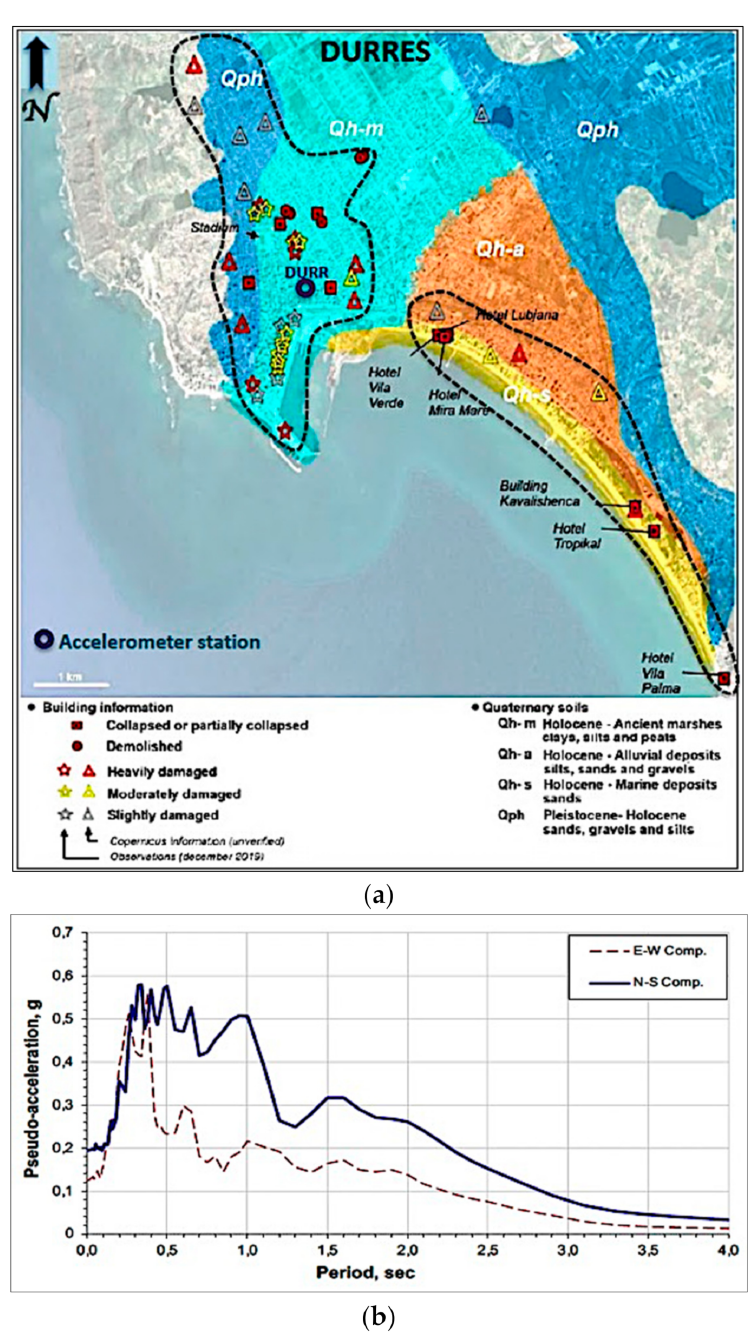
Figure 4. ( a ) Building damage distribution in Durres (not an exhaustive list) after the mainshock of 26 November 2019 (modified from [23]); ( b ) The acceleration response spectrum at the DURR accelerometer station from the 26 November 2019